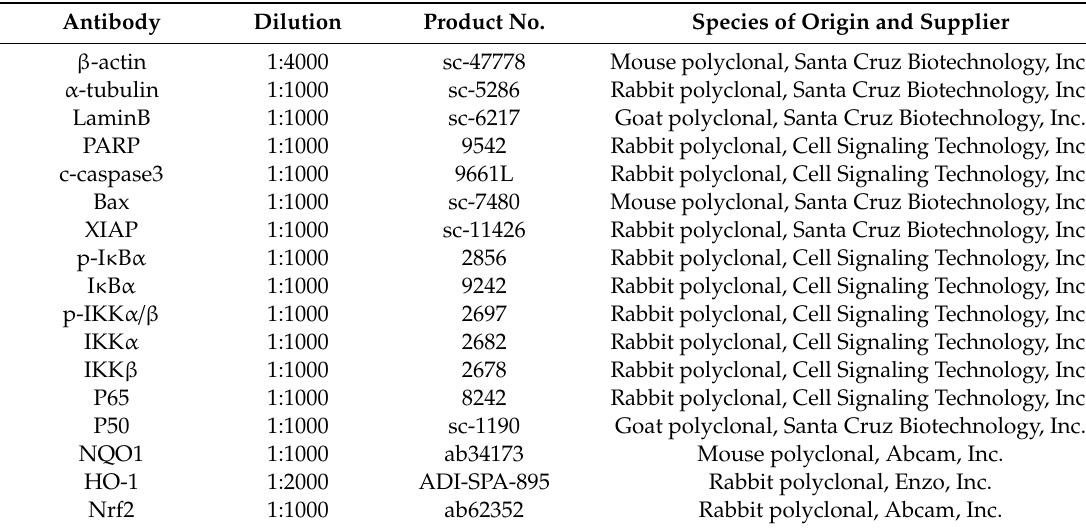
Table 1. List of